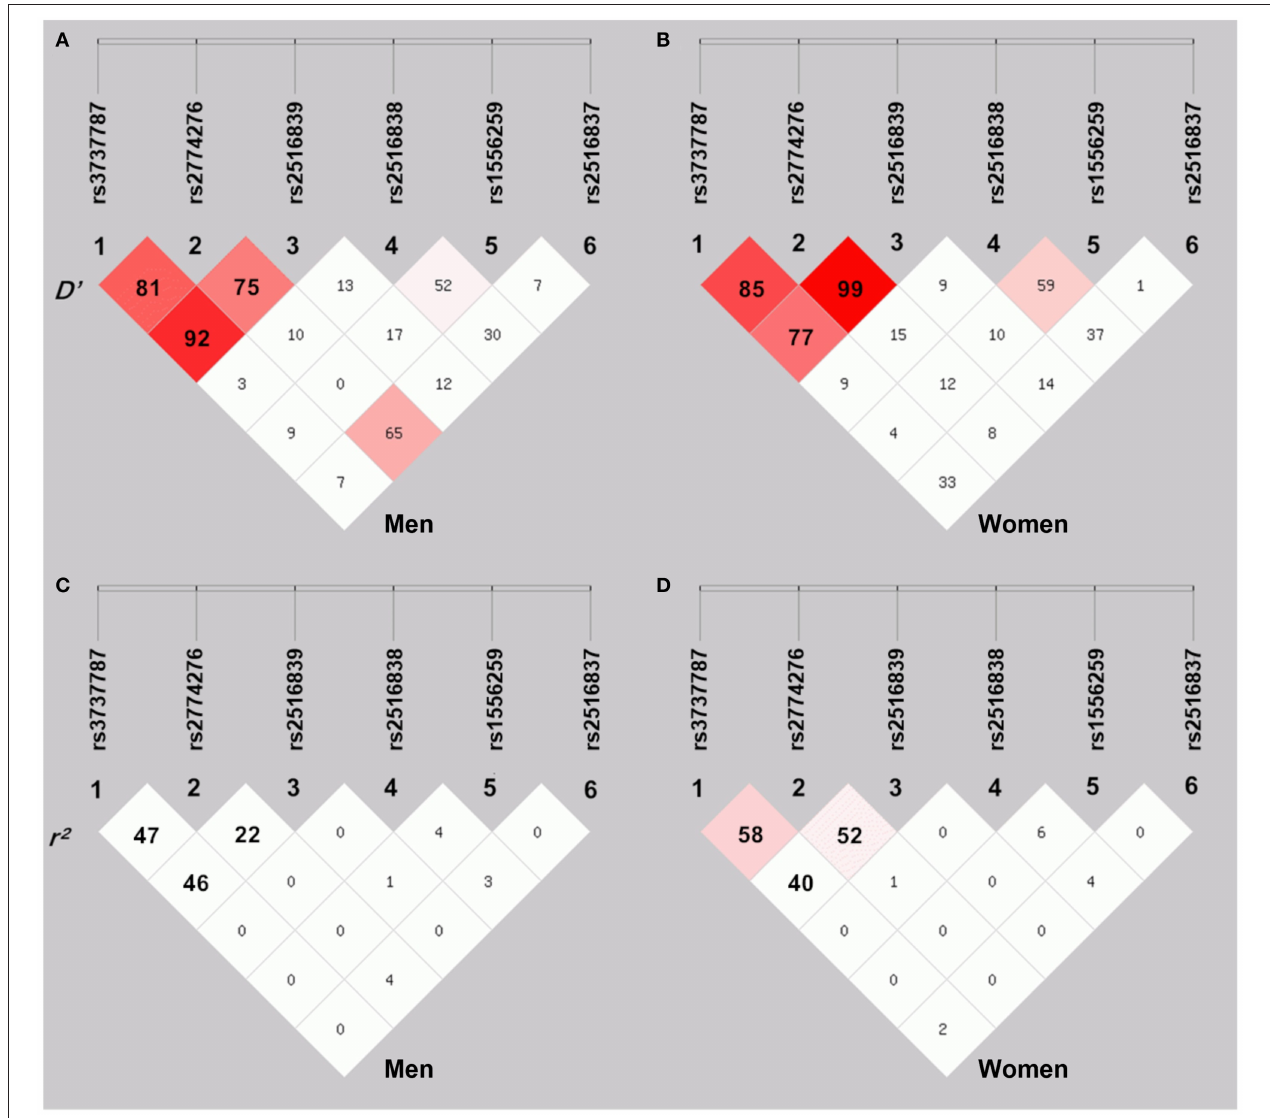
FIGURE 2 | The linkage disequilibrium (LD) represents pairwise D ’ × 100 (A,B) and r ² × 100 (C,D) in men and women.